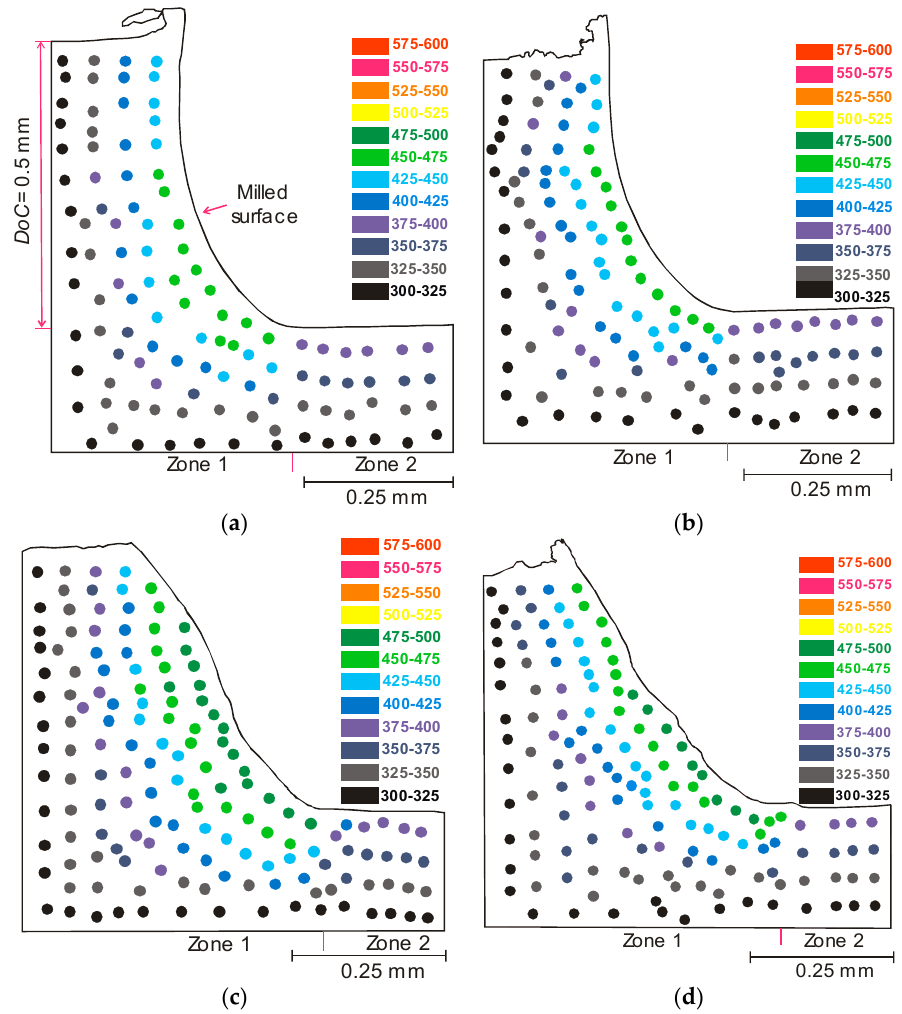
Figure 12. Microhardness (HV) maps on cross-sections of tools near milled surface: ( a ) Tool dry3 , and ( b ) Tool wet3 after the first milling pass; ( c ) Tool dry3 , and ( d ) Tool wet3 after the fourth milling pass, with f t = 0.05 mm.